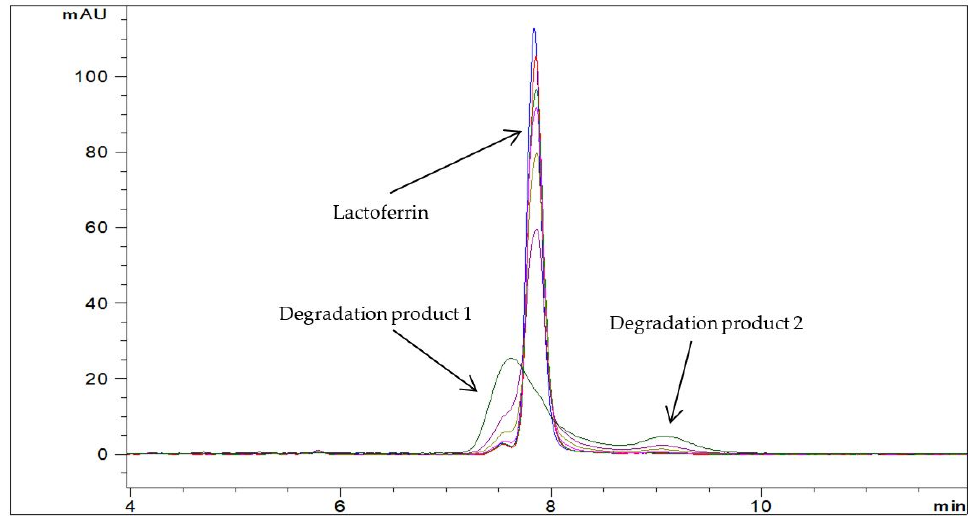
Figure 1. Representative chromatograms of solid Lf isolate sample 1 in Milli-Q water (c = 1.0 mg/mL) at 50 °C at different time points: −− t = 0 min, −− t = 15 min, −− t = 30 min, −− t = 60 min, −− t = 120 min, −− t = 240 min, and −− t = 24 h (RP-HPLC method).